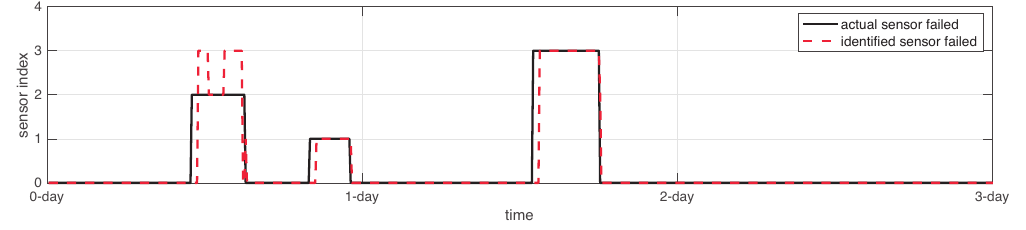
Figure 16. Sensor failure identification response in the system.